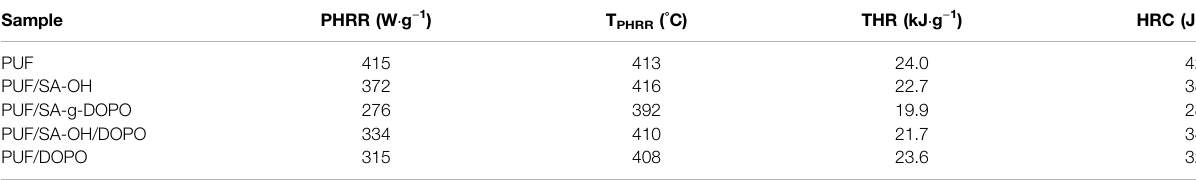
TABLE 2 | MCC results of PUF composites. Sample